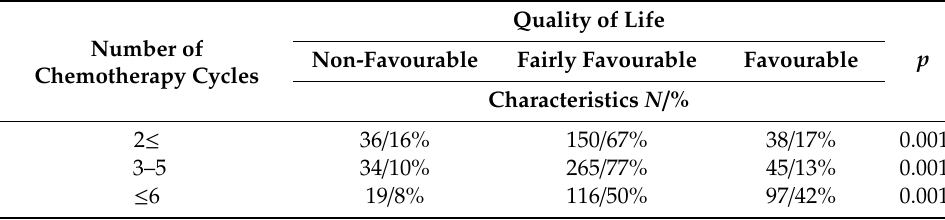
Table 6. Impact of the number of chemotherapy cycles on the quality of